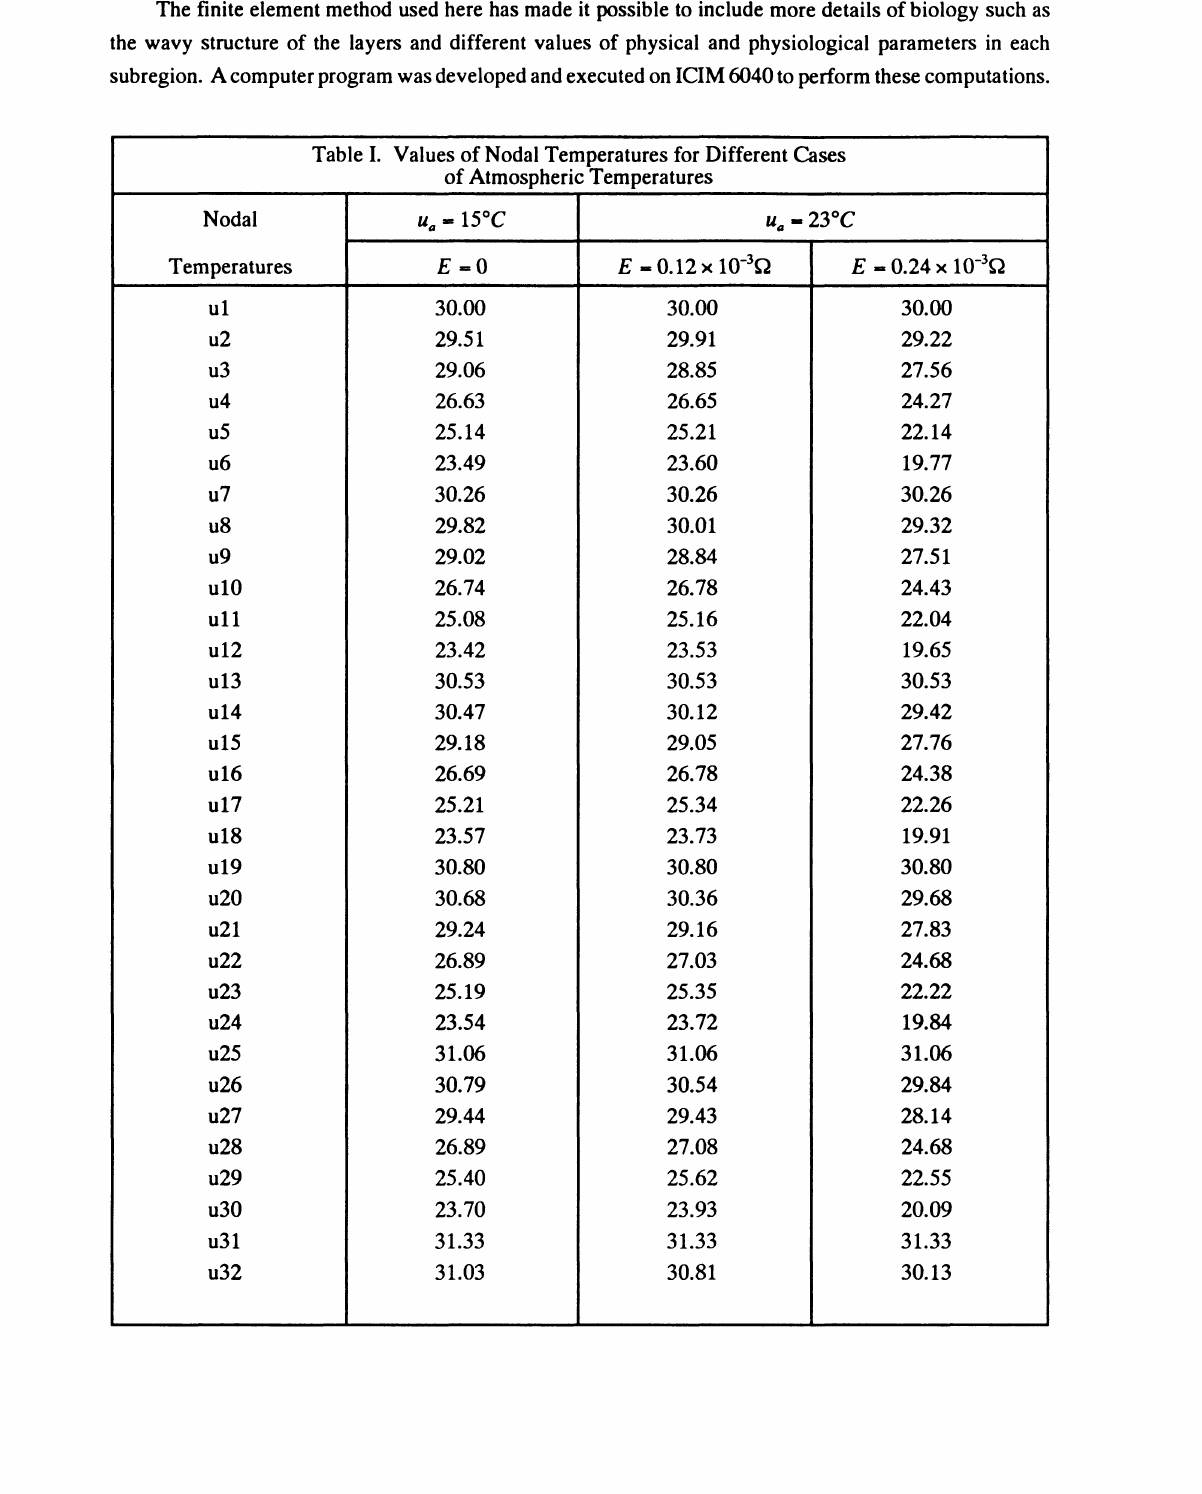
Table I. Values of Nodal Temperatures for Different Cases of Atmospheric